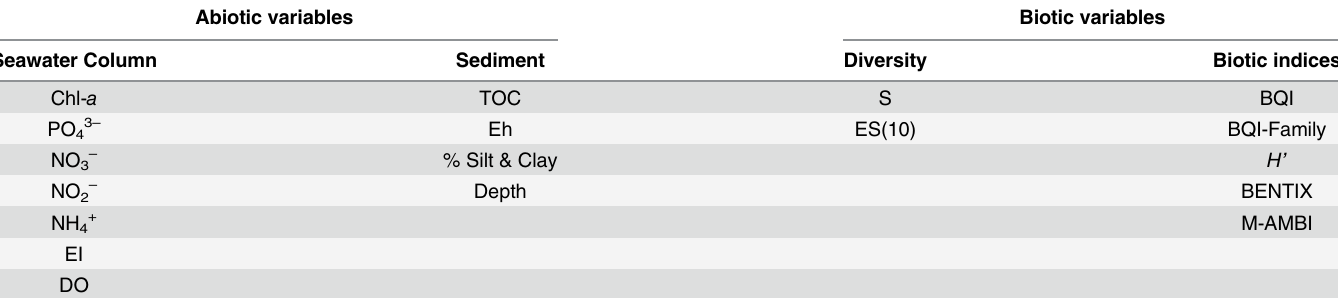
Table 1. List of variables used in the present study. Chl- a , chlorophyll a ; EI, Eutrophic Index; DO, dissolved oxygen; TOC, total organic carbon; Eh, redox potential; S, number of species; ES(10), expected number of species for 10 individuals; BQI, Benthic Quality Index; BQI-Family, Benthic Quality Index – Fam- ily; H ’ , Shannon Diversity Index; BENTIX, Benthic Index; M-AMBI, Multivariate AZTI Marine Biotic